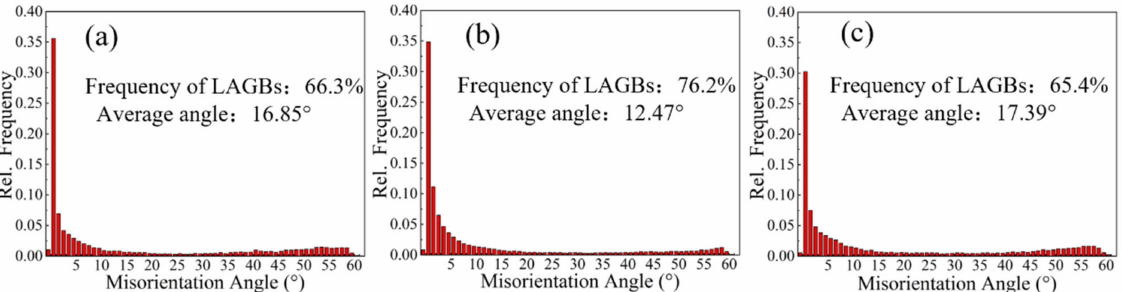
Figure 5. Statistical plots of grain boundary orientation differences of samples at different rolling temperatures after aging treatment: S420 ( a ), S450 ( b ), S480 ( c